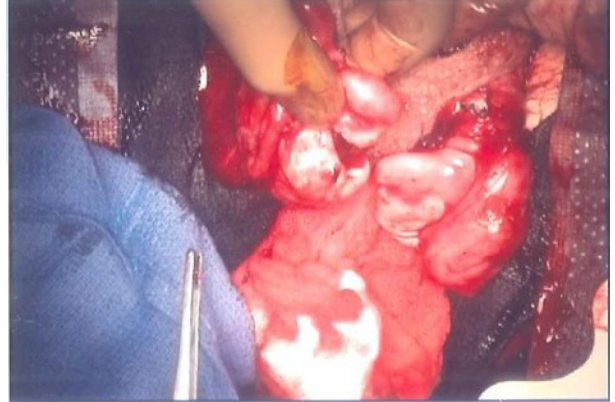
Figure 3. A lateral view of the extent of the right testicular injury.